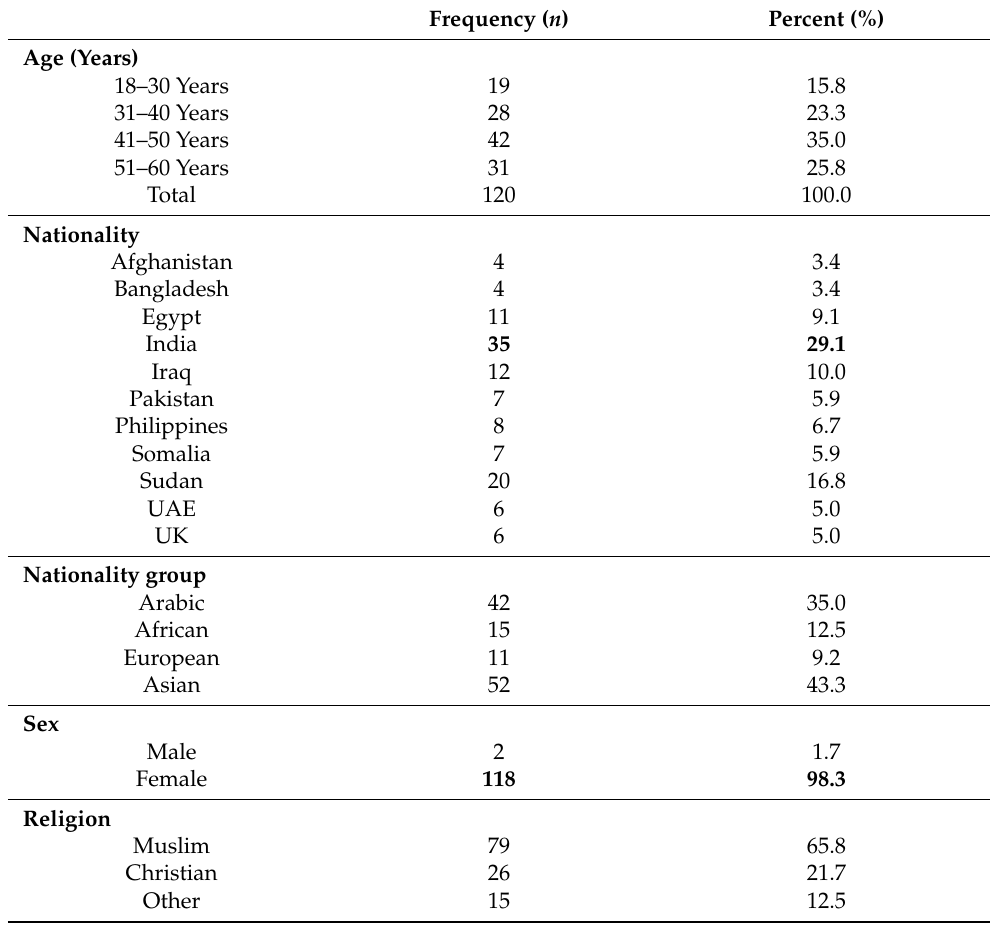
Table 1. Socio-demographic characteristic of the participating group ( n =